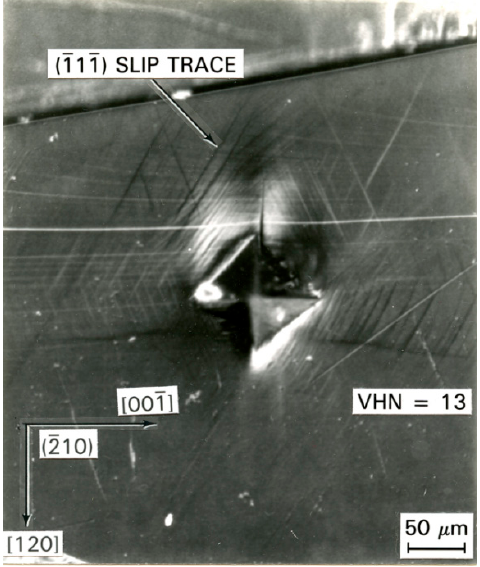
Figure 4. {001} cleavage crack produced by Cottrell-type dislocation reaction at a diamond pyramid indentation impressed into a {210} ammonium perchlorate (AP), NH 4 ClO 4 , crystal surface [17].